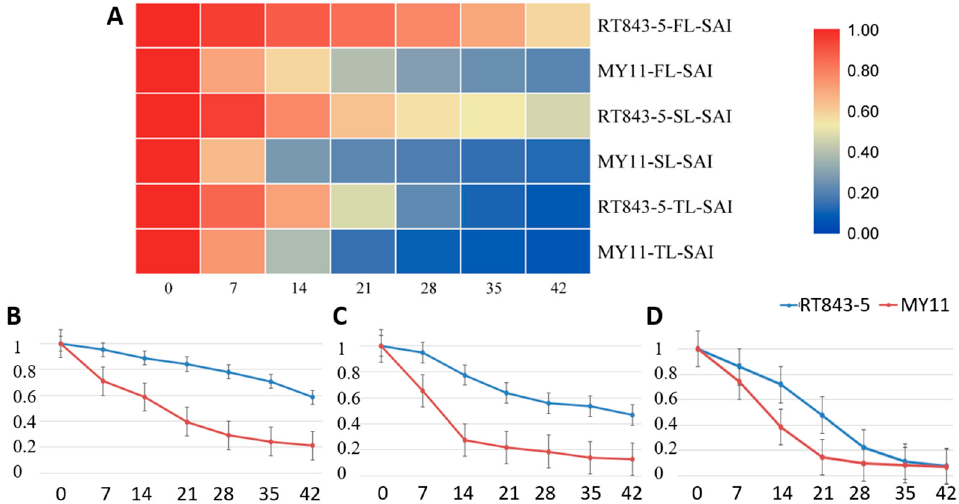
Figure 6. Differences in the SAI (SOD activity index) between RT843-5 and MY11 during leaf senescence after anthesis. ( A ): Heatmap of the changes in the SAI in the FL, SL, and TL. The different colors show the different values of SAI. ( B ): The change curve of the SAI of the FL; ( C ): The change curve of the SAI of the SL; ( D ): The change curve of the SAI of the TL. The Y-axis shows the SAI values, and the numbers on the X-axis show the days after anthesis.